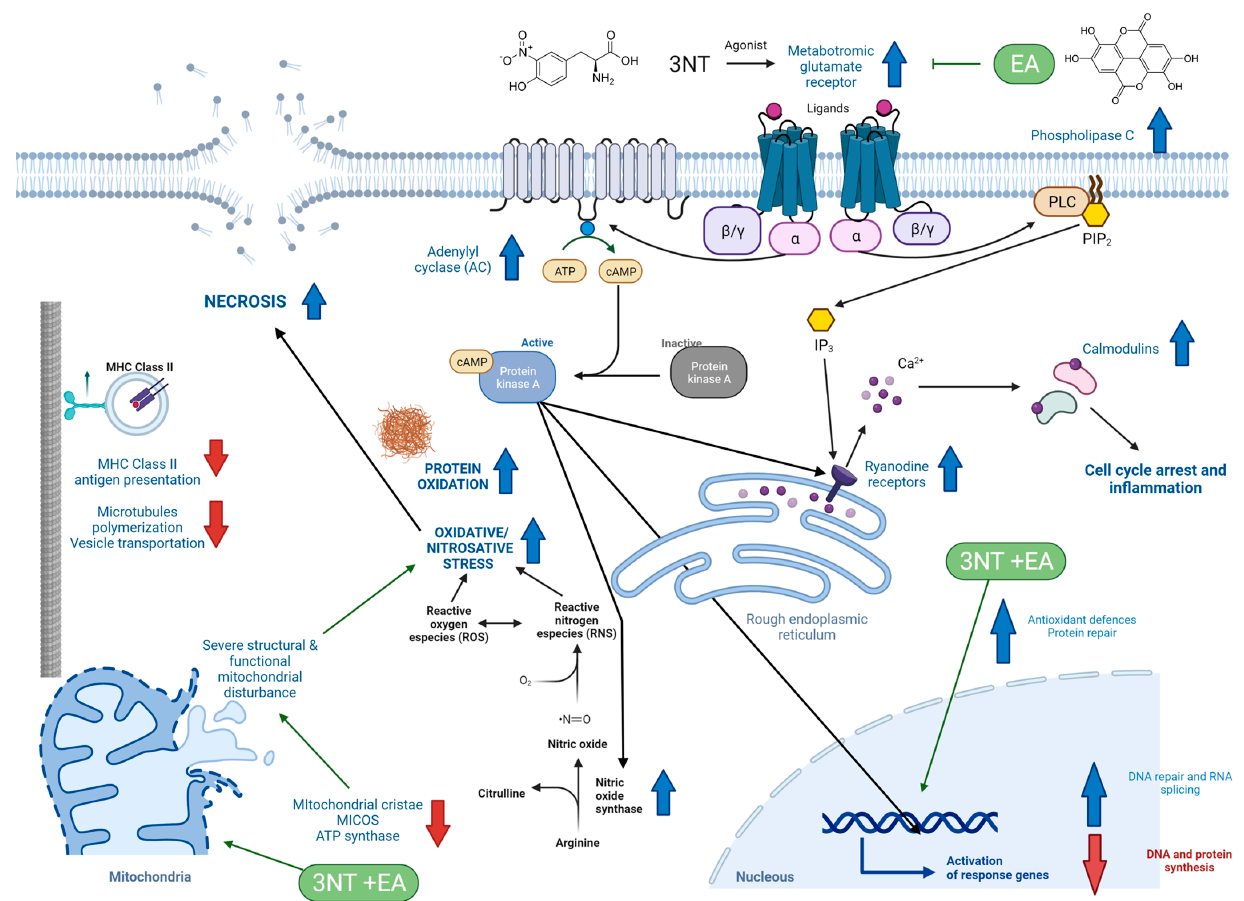
Figure 4. Proposal of underlying molecular mechanisms of the toxicological effects of 200 µ M 3- NT and 200 µ M 3-NT+200 µ M EA for 72 h on differentiated human enterocytes. Upstream head blue arrows indicate higher concentration of proteins/upregulated biological processes in treated enterocytes. Downstream head red arrows indicate lower concentration of proteins/downregulated biological processes in treated enterocytes. Blunt head connectors indicate an inhibited biological process or metabolic pathway. Effect of EA is specifically denoted by green arrows. (For interpretation of the references to colour in this figure legend, the reader is referred to the web version of this